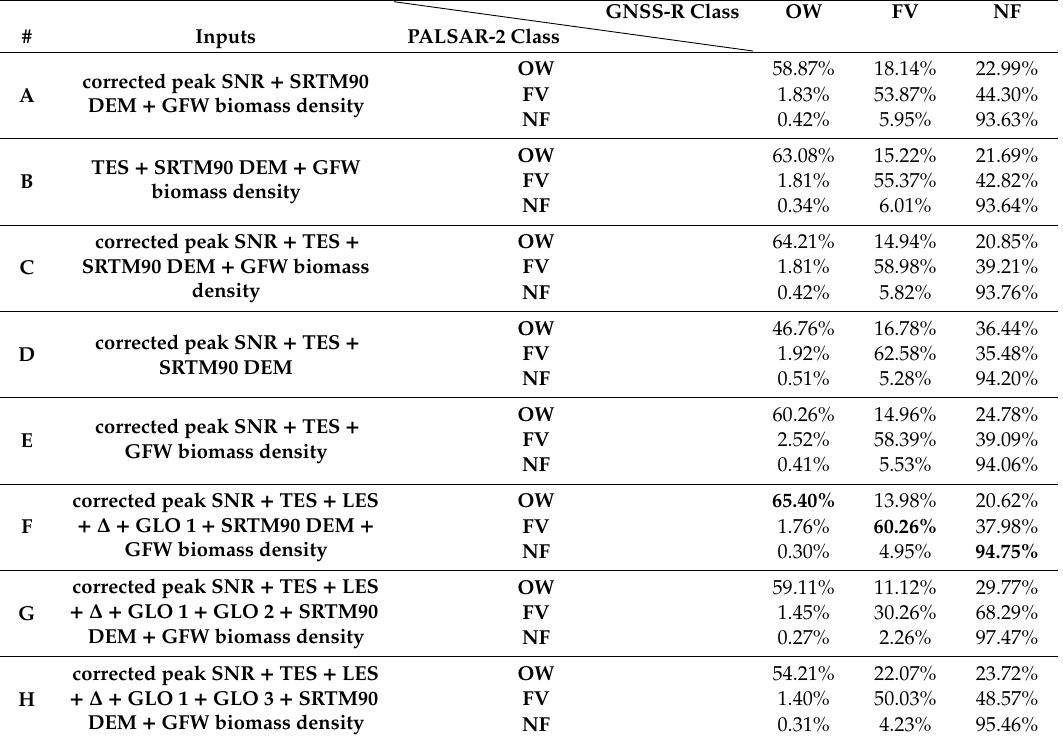
Table 3. Single DT performance assessed through PALSAR-2-based inundation reference maps for cycles 74 and 91 (end of high-flood season and beginning of high-flood season, respectively). This confusion matrix shows the classification accuracy results for di ff erent input combinations and the best results are highlighted in bold. Open Water (OW), Flooded Vegetation (FV), and Non-Flooded Vegetation (NF). Note: the results with the highest performance are marked in bold, input #F. GNSS-R Class PALSAR-2 Class